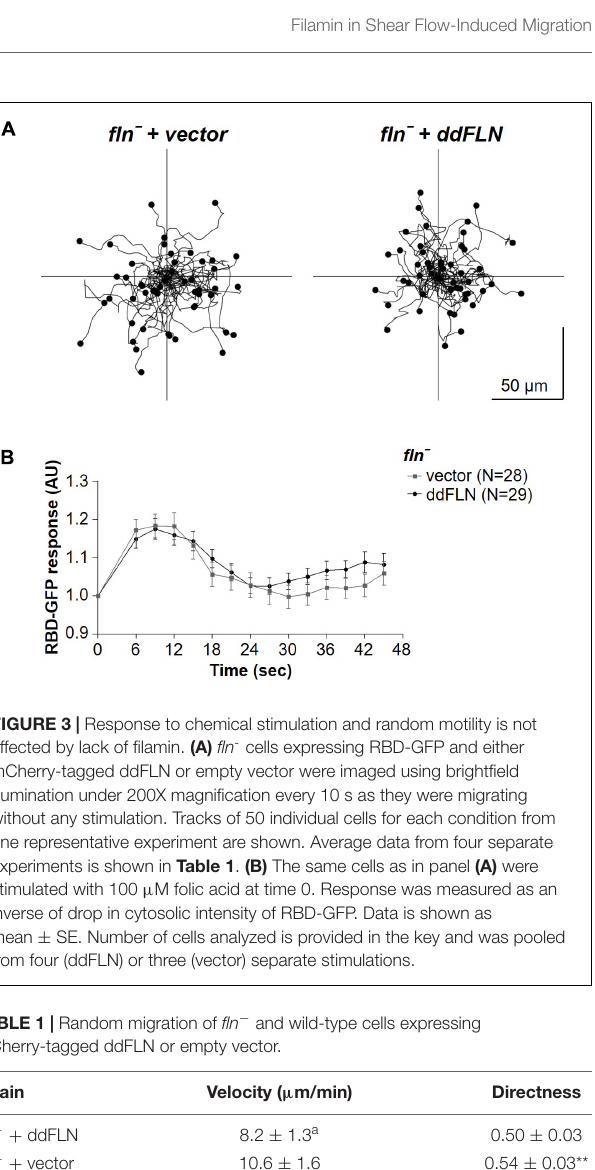
a Values are mean ± SE of three experiments with 50 cells analyzed and averaged for each experiment. Images were acquired every 10 s for 7 min and cells